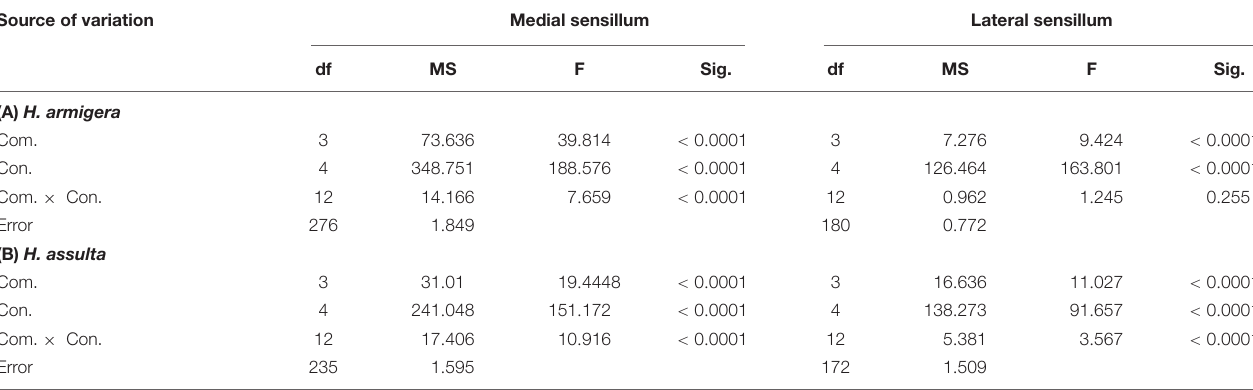
TABLE 2 | Analysis of variance of the gustatory responses of “M2” GRNs in styloconic sensilla of Helicoverpa spp. partitioning effects of compounds and concentrations (GLM-Univariate analysis). Source of variation Medial sensillum Lateral sensillum df